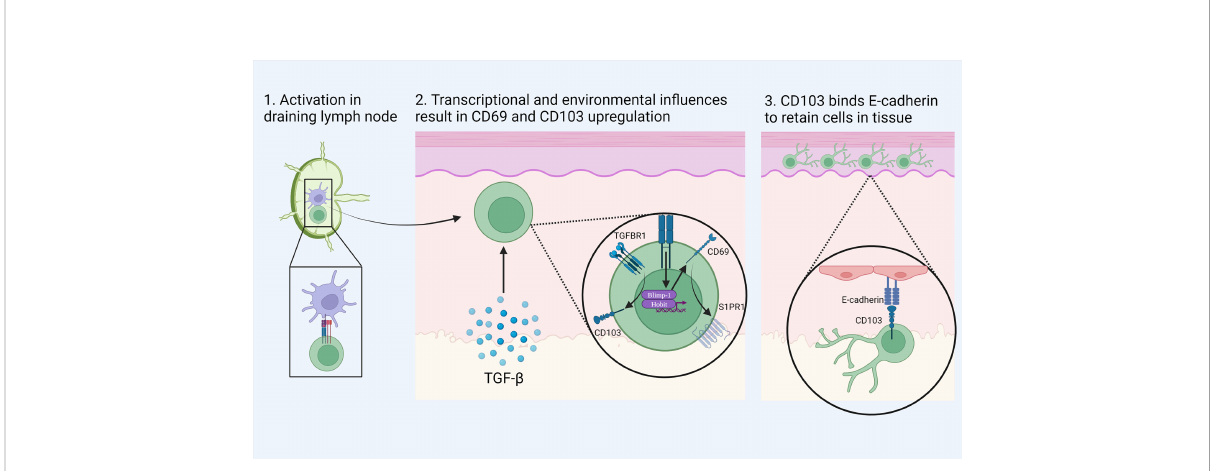
FIGURE 1 Development of skin T RM : Naïve CD8 + T cells are activated by dendritic cells in the local draining lymph node. Upon migration to the skin, local environmental factors such as TGF- b induce the transition to a T RM phenotype. Activation of the transcription factors Blimp-1 and Hobit drives the expression of CD69 which in turn causes the down regulation of S1PR1. In addition, TGF- b stimulates the upregulation of CD103 which binds to E-cadherin in the epidermis to retain cells in tissue. Created with